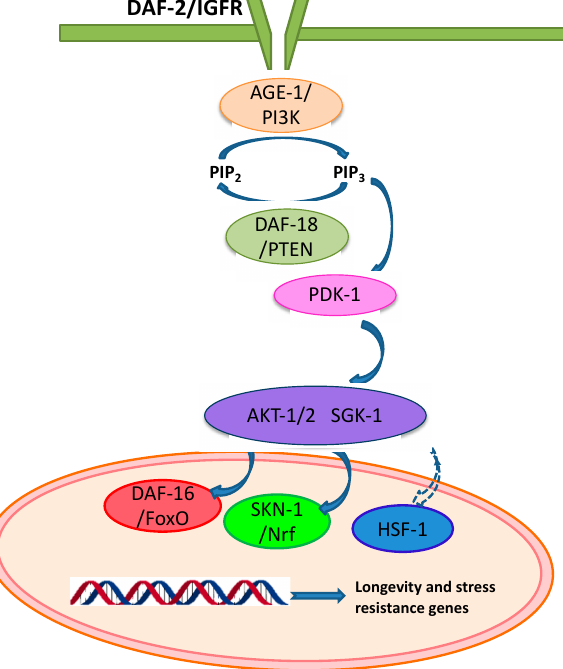
Figure 2. Scheme of the IIS pathway in Caenorhabditis elegans